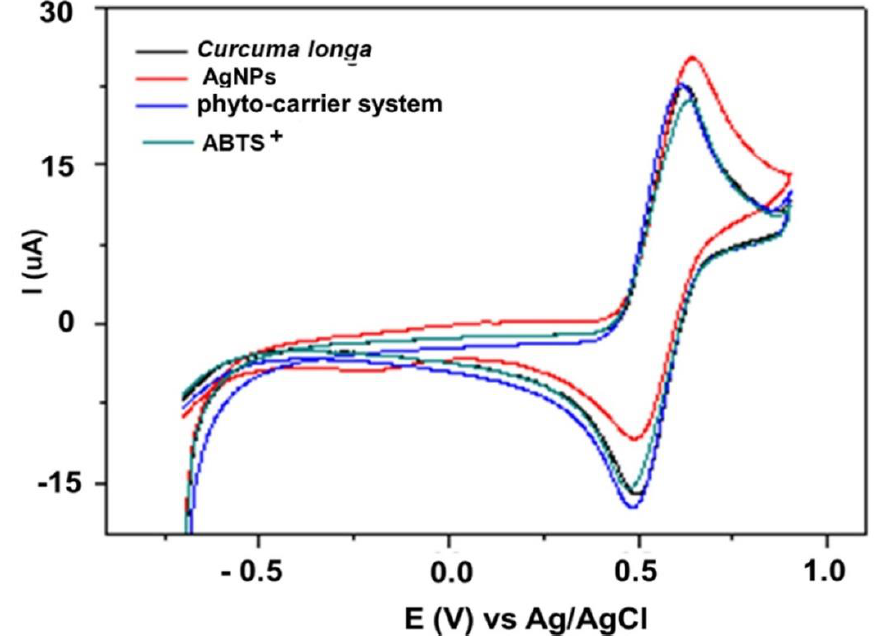
Figure 20. Increase in anodic peak currents in ABTS∙ + voltammetric measurements in the